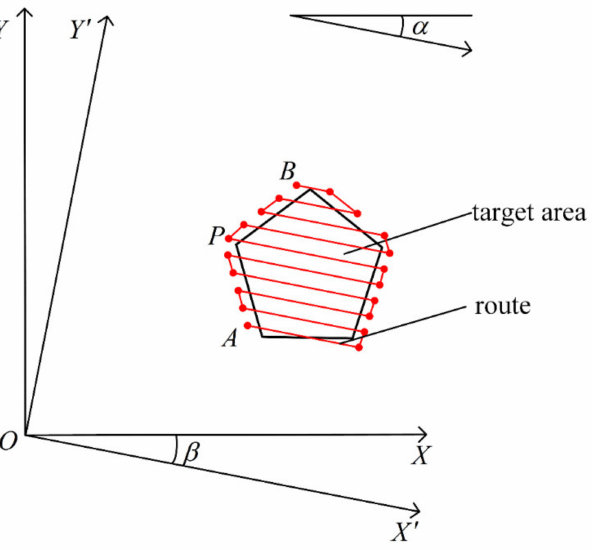
Figure 4. The route with initial heading angle of β . Point A is the first starting point of the route. Point B is the last ending point of the route. Point O is the takeoff point. Point D is the point that has the minimum Y -coordinate value among the vertices of the operation